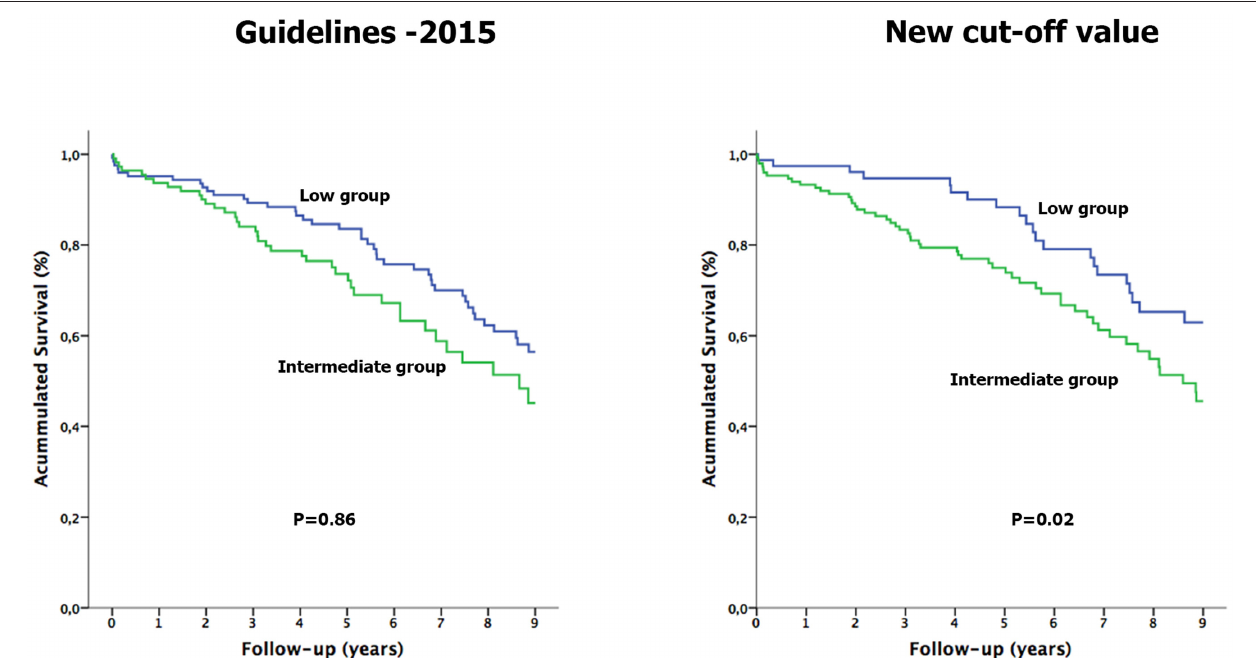
FIGURE 1 | Kaplan-Meier survival curves analysis of patients with tricuspid regurgitation, according to ESC/ERS guidelines and the new cut-off point thresholds.